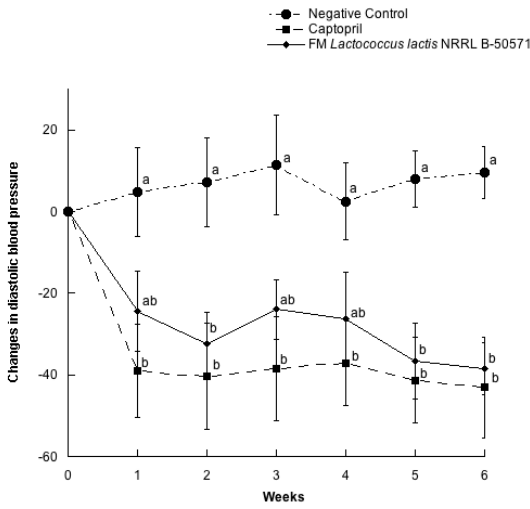
Figure 4. Change in diastolic blood pressure in spontaneously hypertensive rats with different treatments. Negative control: purified water; Captopril: 40 mg/kg body weight; FM L. lactis NRRL B-50571 (ad libitum): fermented milk with L. lactis NRRL B-50571. Data are presented as means ±